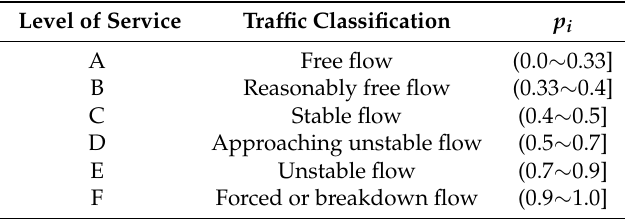
Table 1. Level of service and traffic classification